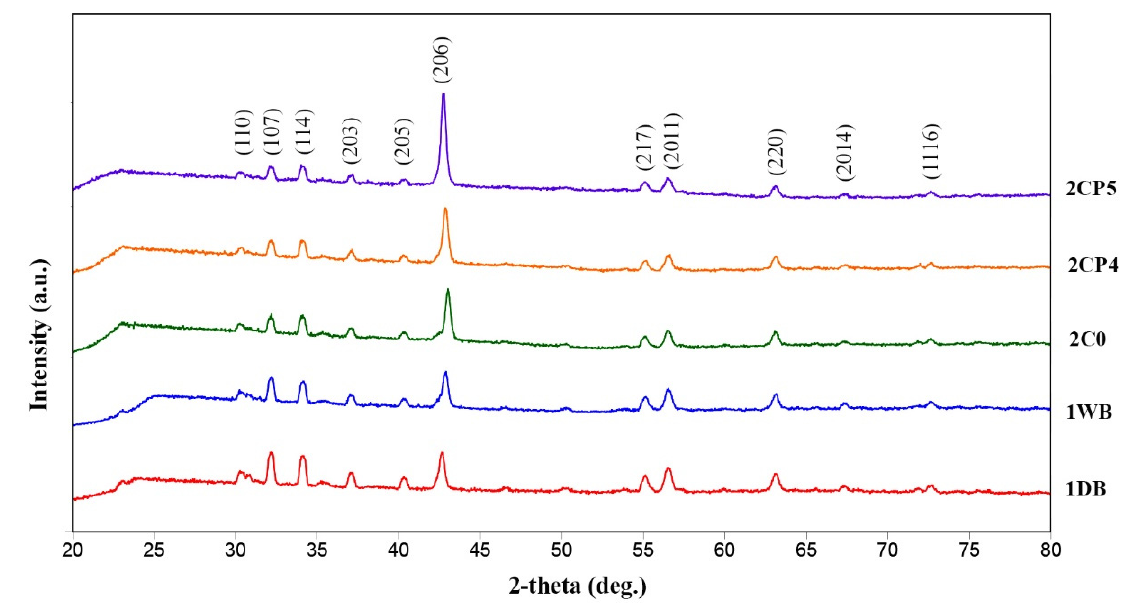
Figure 3. XRD spectra of the dry- and wet-pressed bar magnets (1DB and 1WB), and magnets from paste-injection molding (2C0, 2CP4 and 2CP5).